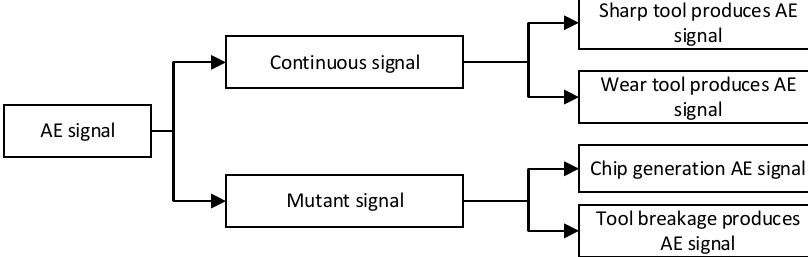
Figure 4. Type of AE signal generated during tool